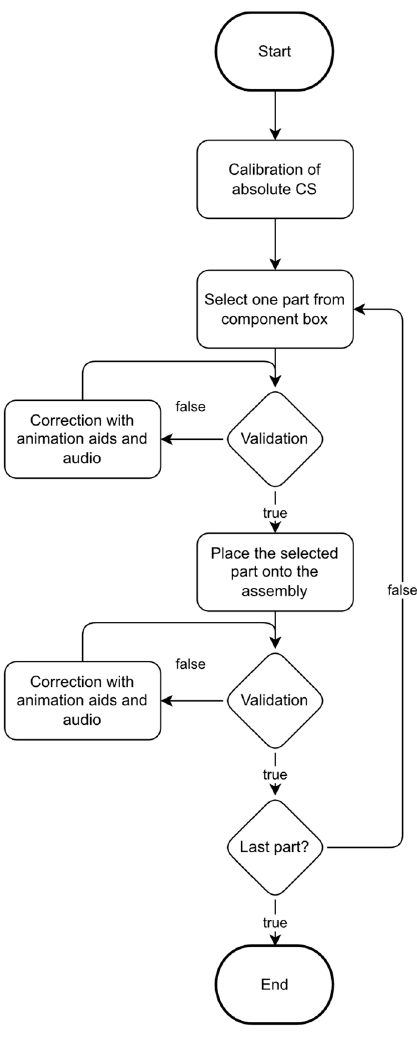
Figure 4. Flow chart displaying the workflow of the application.